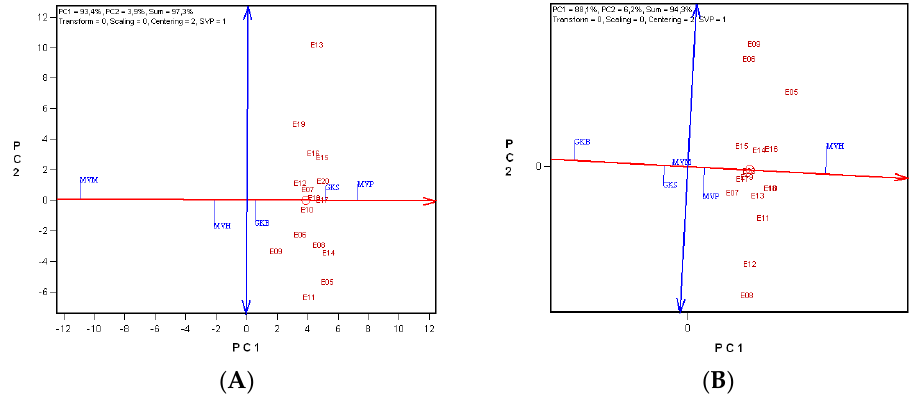
Figure 2. Ranking biplots based on the mean gluten index ( A ) or mean Minolta b* value ( B ) and stability of durum wheat cultivars over 16 years. Environment-centred (Centering = 2) GGE biplot analysis based on non-scaled data (Scaling = 0) with environment-metric (SVP = 2) plotting. E05–E20: years 2005–2020; ‘GKB’, ‘GKS’, ‘MVM’, ‘MVP’, ‘MVH’: genotypes; PC1, PC2: principal component variables; the average environment axis (AEA) is represented by a thick red line; values on the blue axis, supplied with arrows, represent the stability of the cultivars. The intersection of the two axes: cultivar mean; O: year mean.